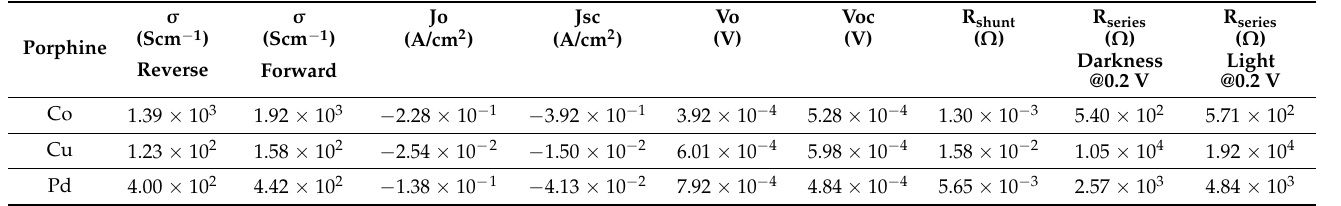
Table 3. PEDOT:PSS-metalloporphine composite films electrical